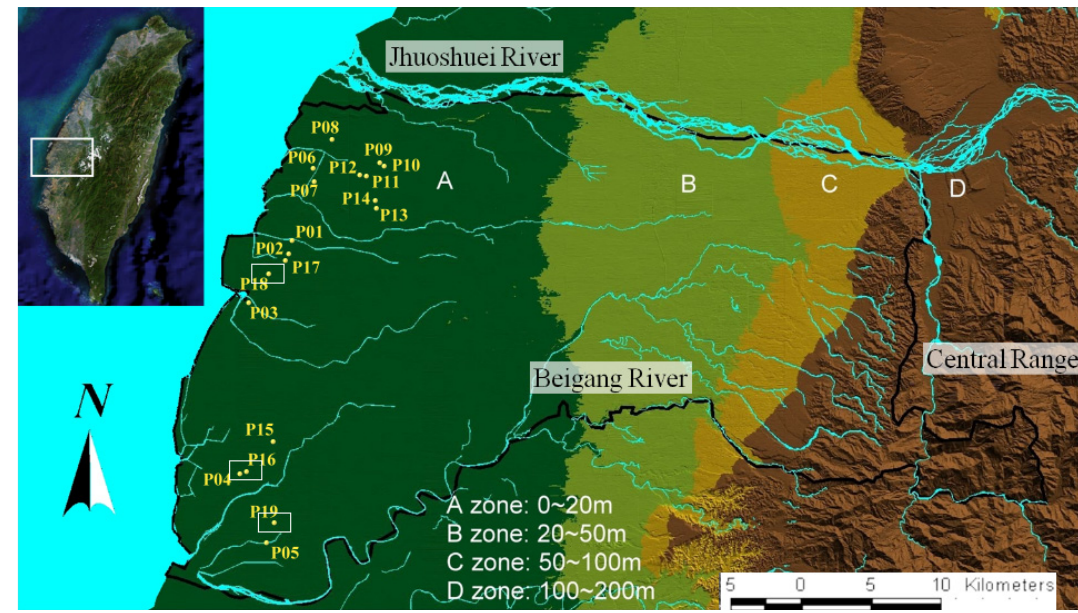
Fig. 3. The location and topography of Yunlin county, Taiwan and the 19 representative inundation locations.